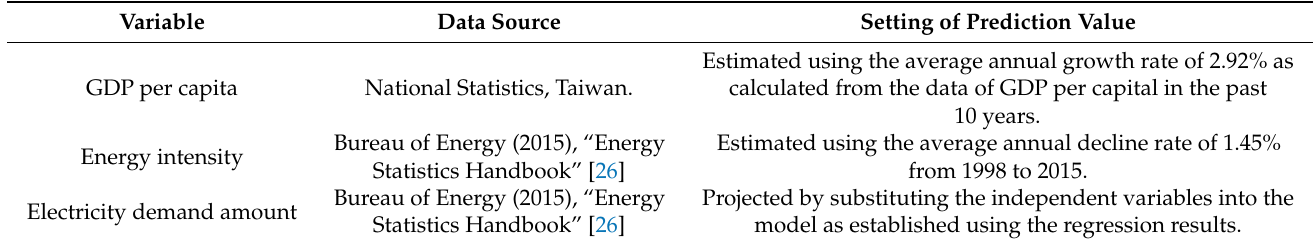
Table 4. Data sources and setting of